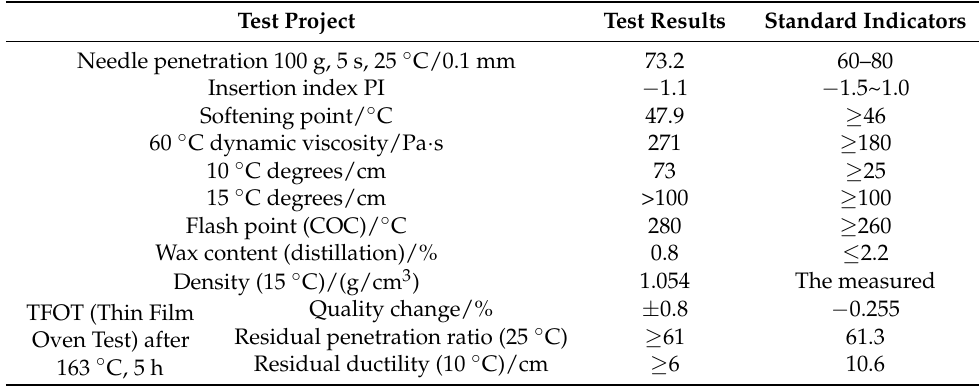
Table 1. Performance indexes of 70# base